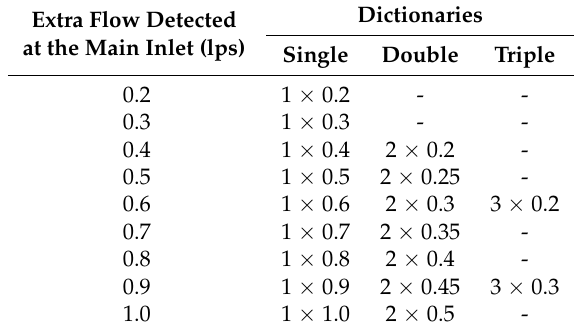
Table 5. The scheme to select dictionaries used to quantify leaks.